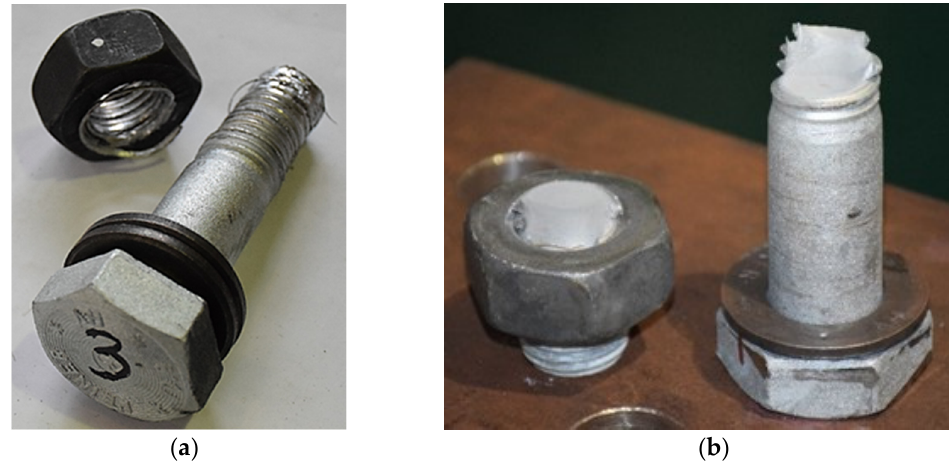
Figure 1. Failure of the HV bolt under pure tension ( a ) and under combined tension and bending in a flush end plate connection ( b ) [2,3].